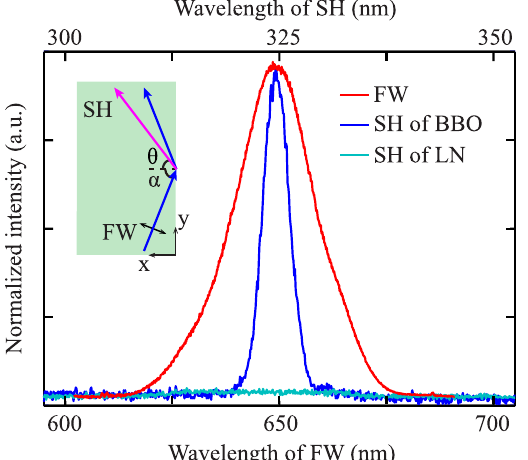
Figure 1. Spectrum of the FW and harmonic wave generated at the boundary of BBO and LN. The center wavelength of FW and SH is 650 nm and 325 nm, respectively. The inset is experimental schematic of the generation of UV second-harmonic wave generated on the boundary of the BBO (or LN)